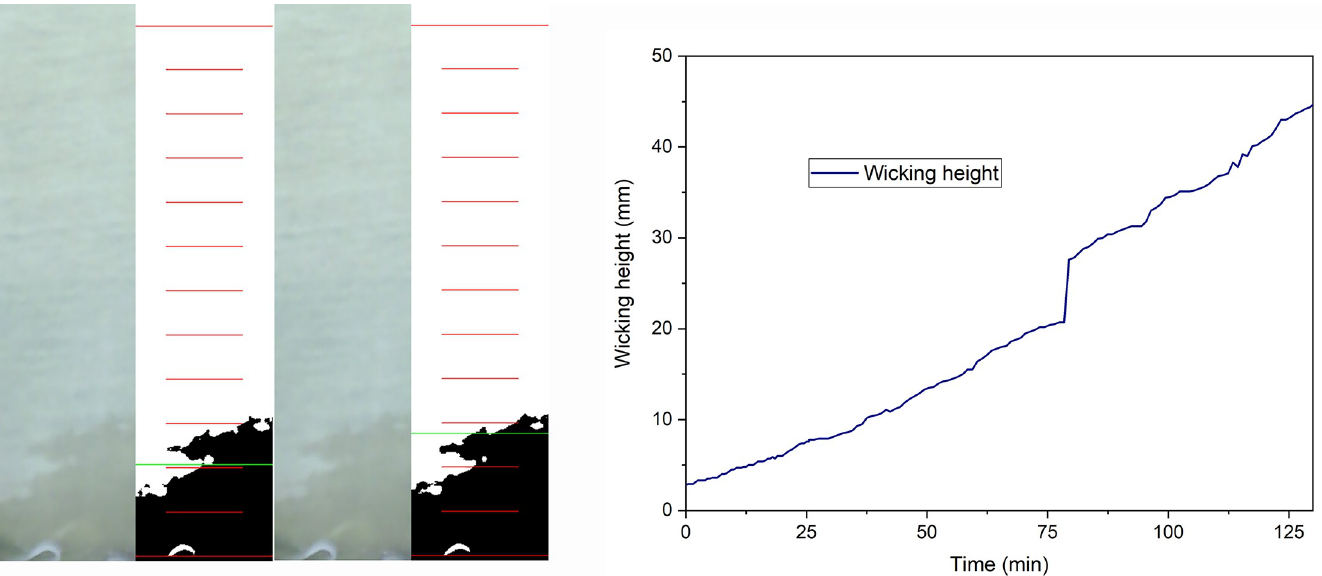
Fig 10. Example of recorded “step” a) Two consecutive images b) Determined